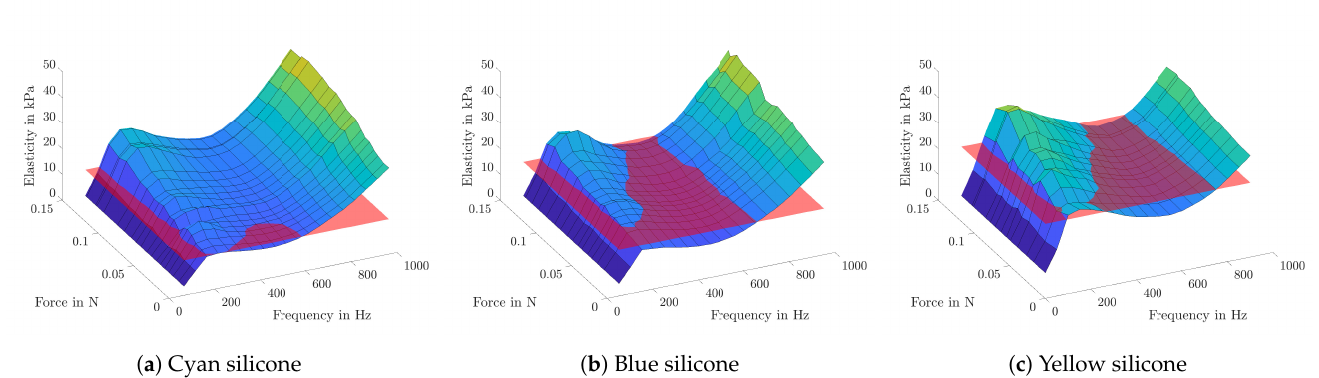
Figure 7. For different pipette contact pressures, the elasticity values are plotted against the applied frequency. The red plane symbolizes the static elasticity of each sample, which are 6.04kPa for cyan ( a ), 11.56kPa for blue ( b ) and 18.77kPa for yellow silicone ( c ).